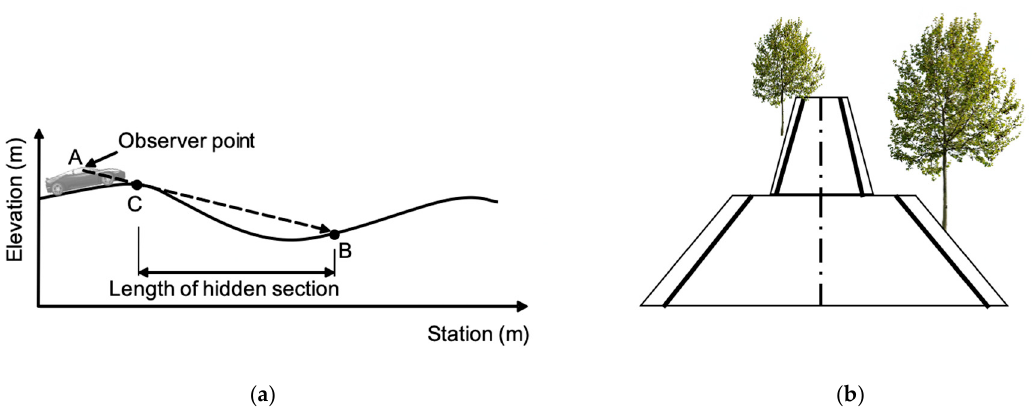
Figure 3. Hidden sight dip: ( a ) road vertical profile; ( b ) road frontal 3D view.